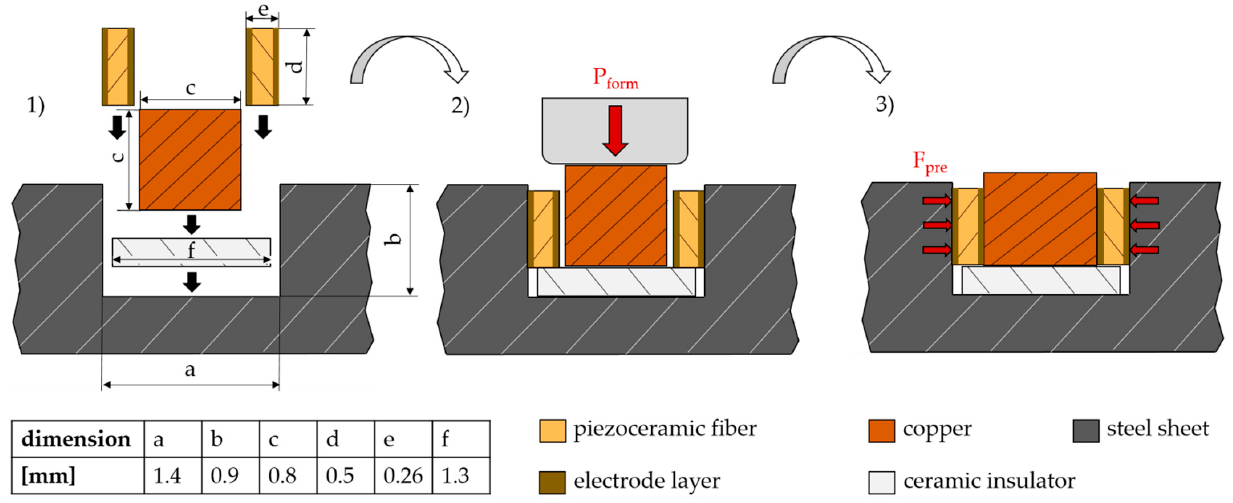
Figure 2. Components and steps for manufacturing the SIP; ( 1 ) Assembly, ( 2 ) Joining by forming, ( 3 ) Joined components. ( 3 ) Joined